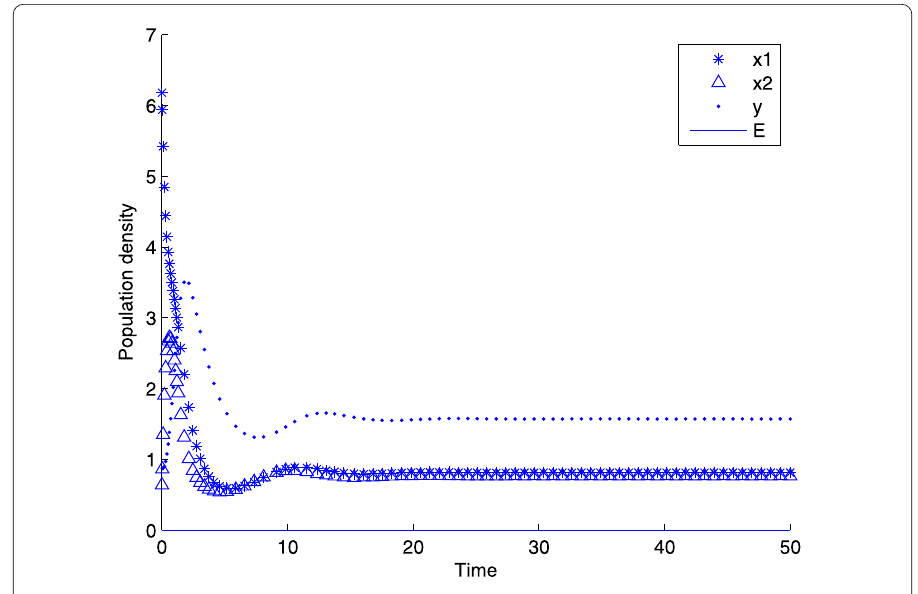
Figure 1 The state response of system (4) with τ = 0.7234 at P 3 . The state response of system (4) with τ = 0.7234 at P 3